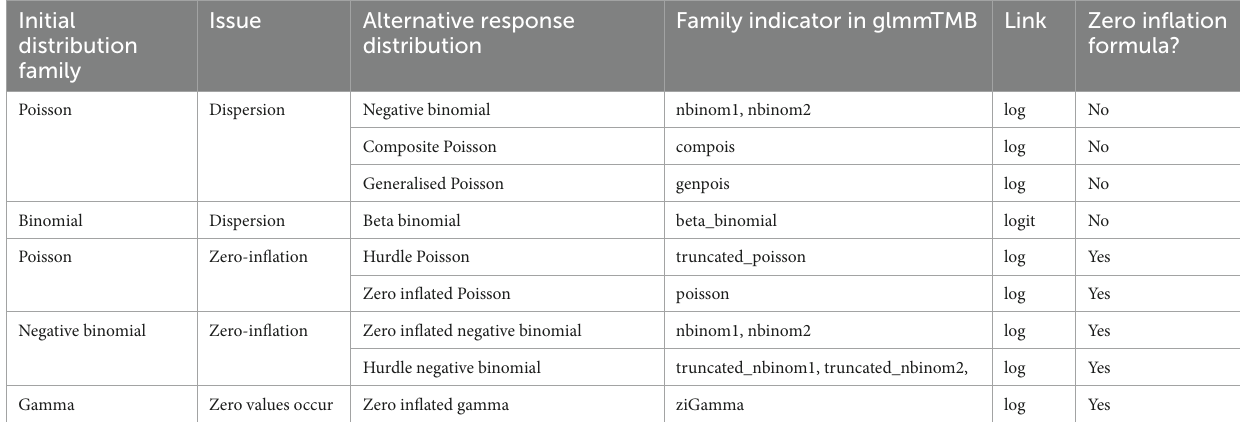
TABLE 2 Alternative distribution families to account for issues with dispersion or